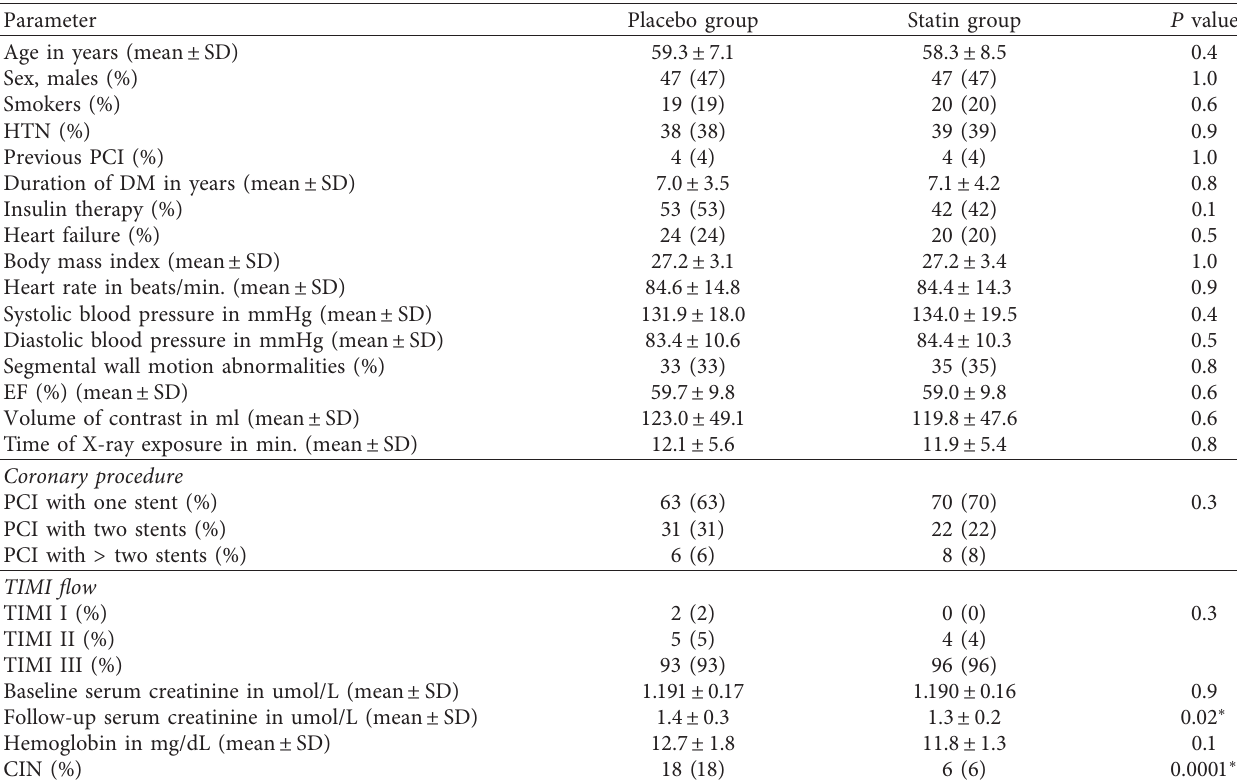
Table 2: Demographic, clinical, echocardiographic, and laboratory data of the two groups.